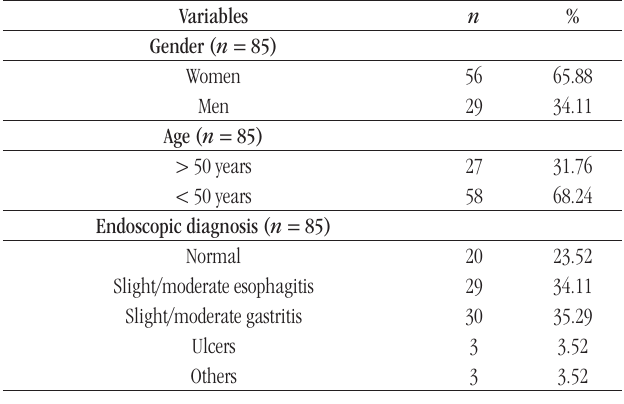
taBLE 1 − Distribution of gender, age and endoscopic diagnosis of Helicobacter pylori , Rio Verde (GO), 2015